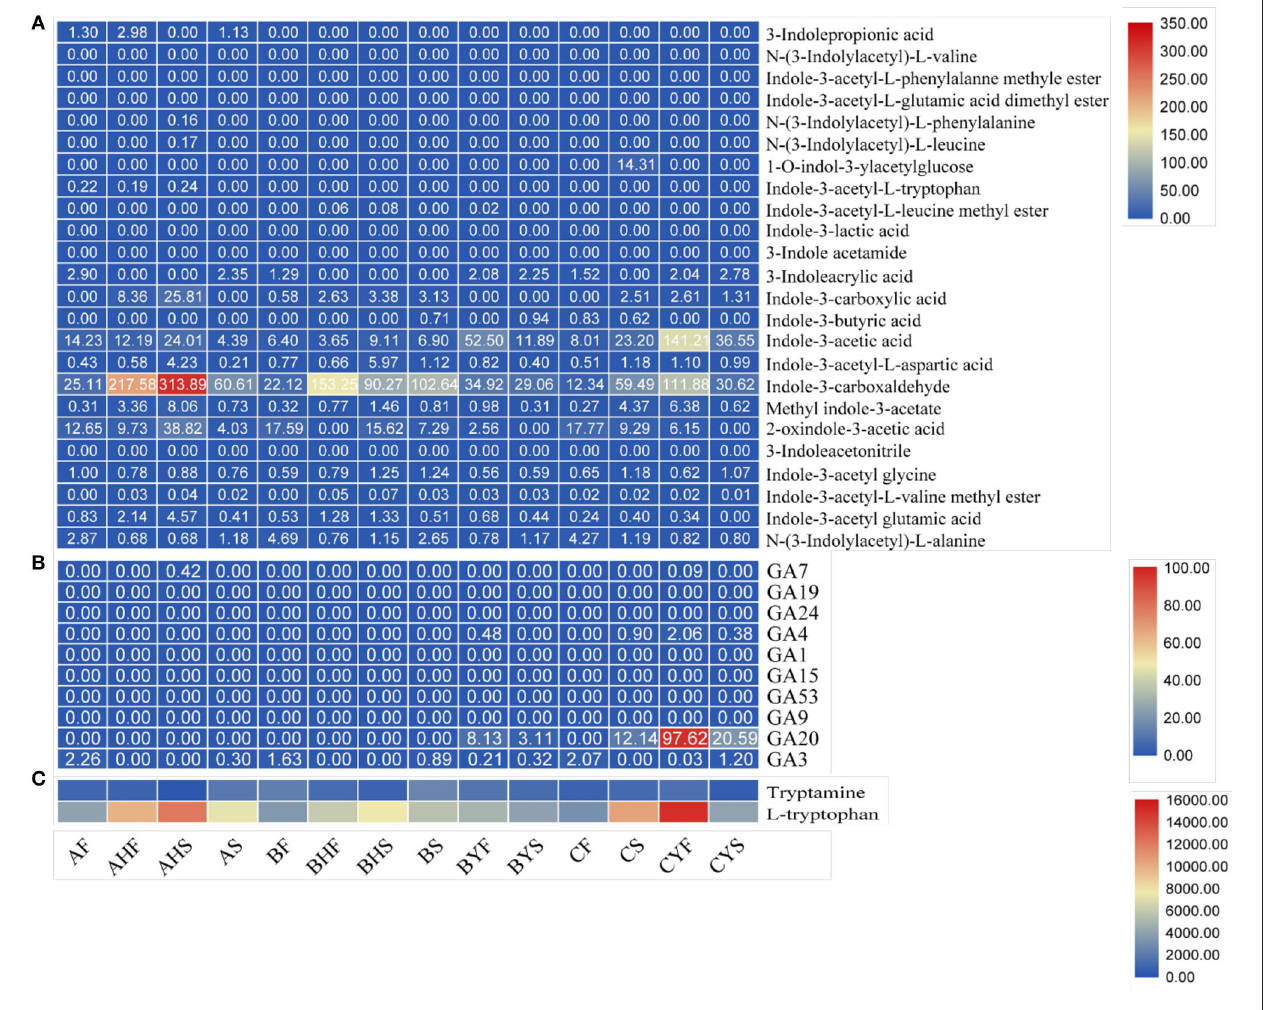
FIGURE 8 | The relative content of auxins and GA in 14 mango flowering tissues quantified based on the ion intensity of different compounds. (A) auxins, (B) GA, and (C) amino acids (also classified as auxins in our